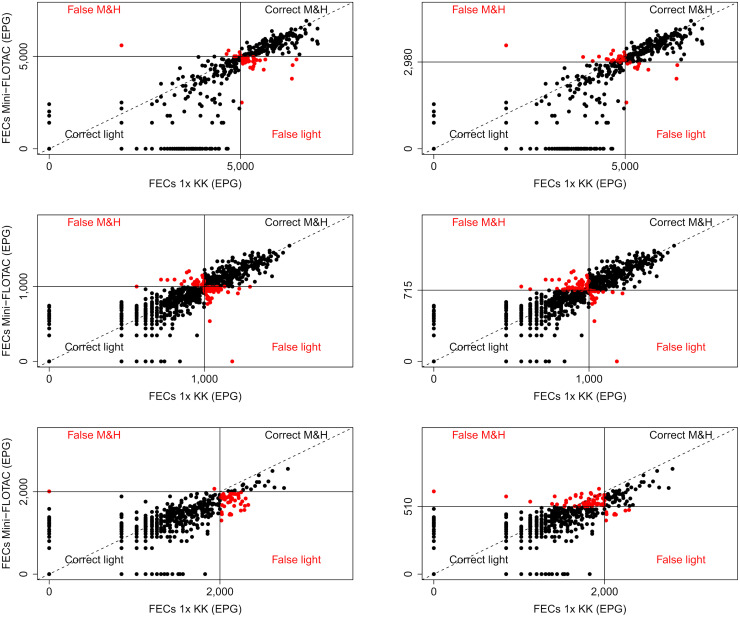
Agreement in classifying infection intensities for Mini-FLOTAC when applying WHO and method-specific thresholds.The scatter plots represent the degree of agreement between Mini-FLOTAC and a single Kato-Katz (1x KK; reference method) in classifying infection intensity based on World Health Organization (WHO; Table 1) or the method-specific thresholds (Table 4) for Ascaris, Trichuris and hookworms. The full black dots indicate that intensity of infection was correctly classified as light (bottom left quadrant) and moderate-to-heavy (M&H; top right quadrant). The red dots indicate that intensity of infection was falsely classified as light (bottom right quadrant) and M&H (top left quadrant). The full lines represent the thresholds, the dashed lined represents the line of equality.